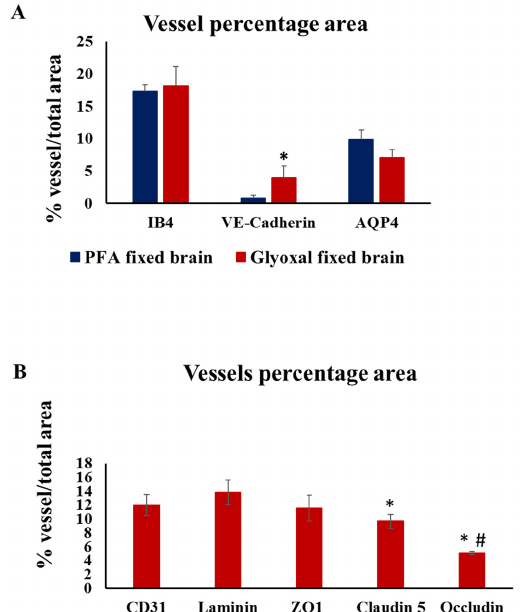
Figure 5. Quantitative analysis of the vascular network. ( A ) Angiotool analysis of percentage vessel area in PFA fixed brain versus glyoxal fixed brain, based on immunofluorescence after staining for vascular markers (IB4-isolectin, VE-cadherin and Aquaporin) and graphical representation of the analysis performed on three different regions of interests. The data shown represent the mean ± SD; statistical analysis was performed with unpaired t -test; n = 3. * p < 0.05 PFA fixed brain sample versus glyoxal fixed brain samples. ( B ) Angiotool analysis of percentage vessel area in glyoxal fixed brain, based on immunofluorescence after staining for vascular markers (CD31, Laminin, ZO-1, Claudin-5, and Occludin) and graphical representation of the analysis performed on three different regions of interest. ANOVA and a post hoc Tukey’s test were performed between groups for finding the statistical significance. A value of p < 0.05 was considered statistically significant. * p < 0.05 compared to laminin. # p < 0.05 compared to CD31.